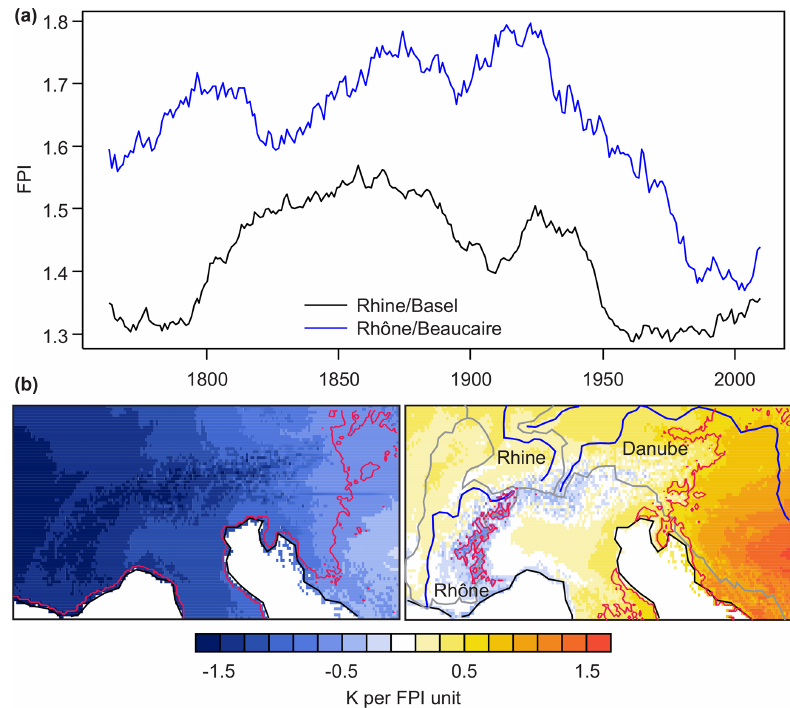
Figure 6. (a) FPI index for the Rhine in Basel (May to October) and the Rhône in Beaucaire (November to April), smoothed with a 30-year moving average. (b) Regression map of detrended seasonal (May to October and November to April, respectively) mean temperature in HISTALP onto the corresponding (detrended) FPI indices. Red lines indicate significant ( p < 0.05)